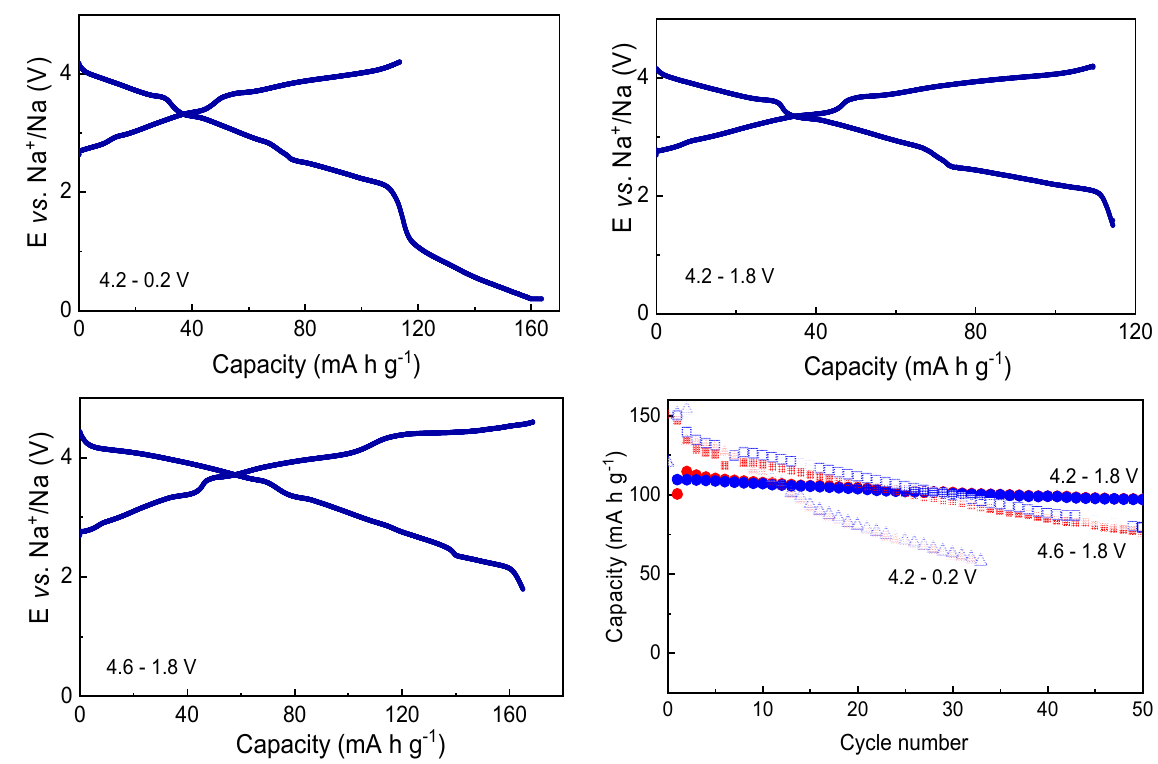
Figure 2. First galvanostatic charge–discharge cycle of Na 0.8 Co 0.8 Ti 0.2 O 2 performed within different potential windows, and capacities for 50 cycles obtained during cycling within different potential windows (Electrolyte: 1M NaClO 4 in EC/PC + 5% FEC). Red symbols correspond to the charge process, while blue symbols to the discharge.